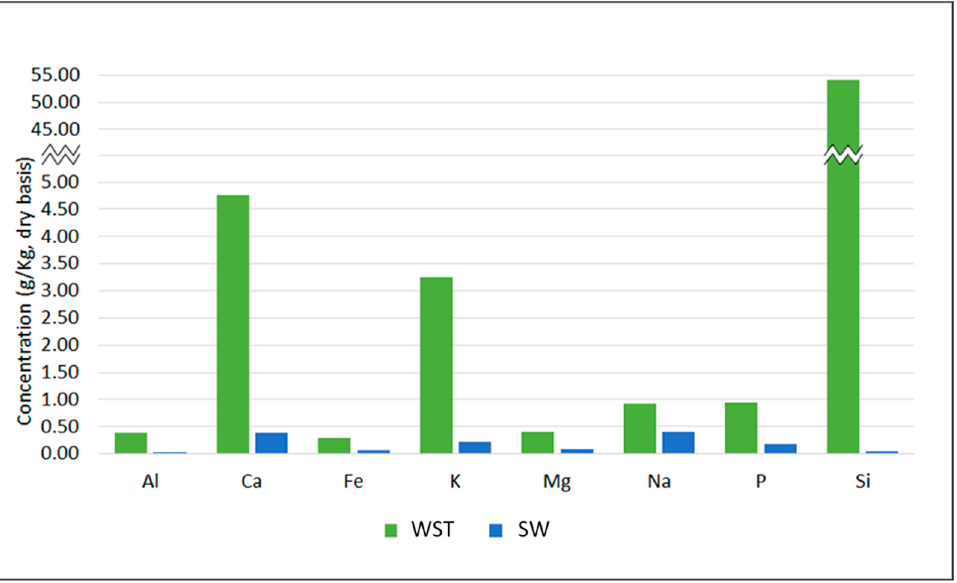
Figure 3. Mineral compounds quantified in WST and SW by the ICP-AES analysis [3].